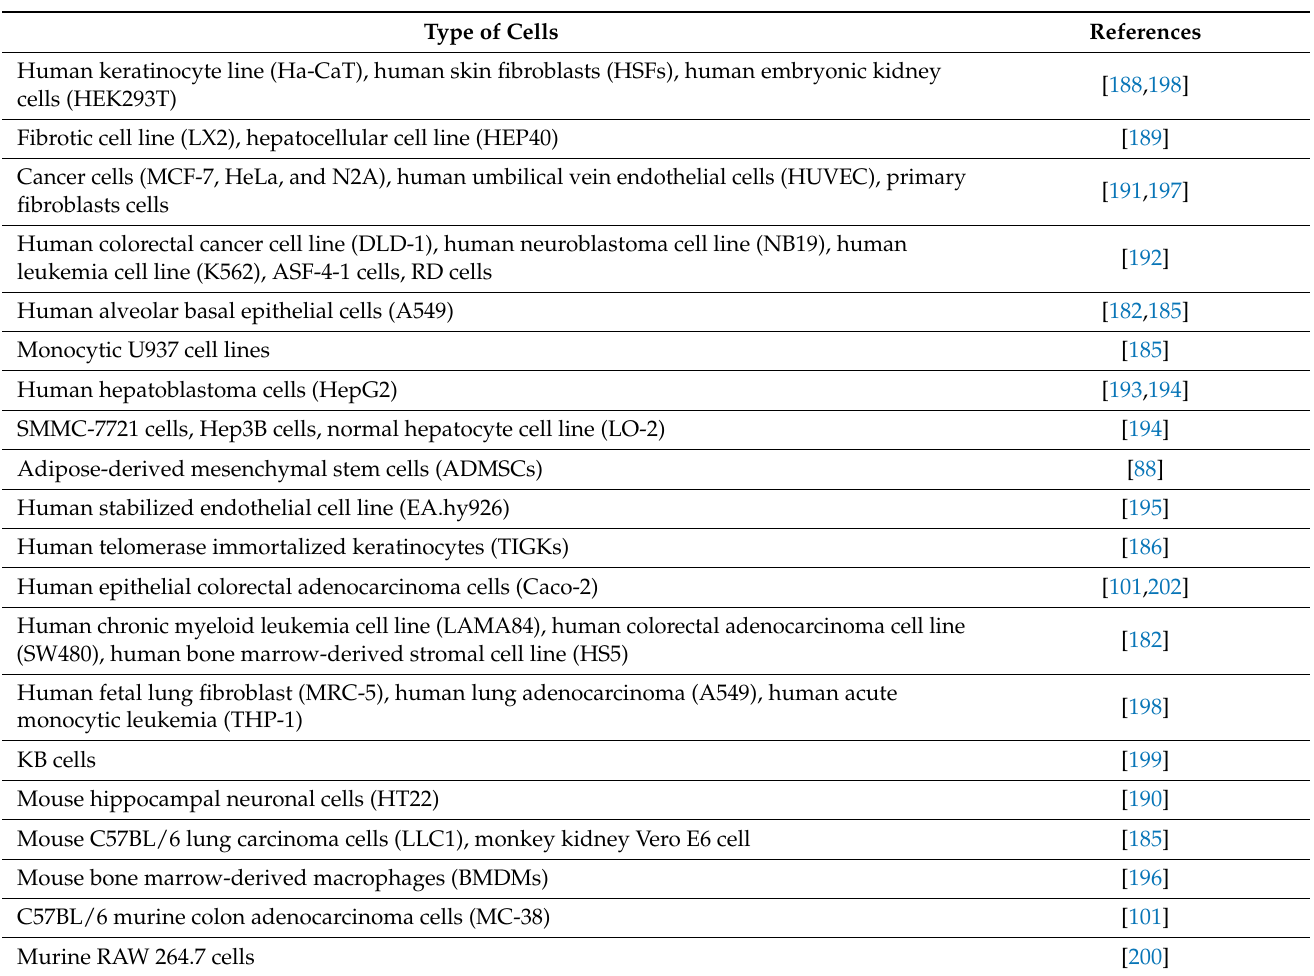
Table 3. Cells used in the experiments on the capacity of the vesicles to act as a potential biomedical therapeutical agent.